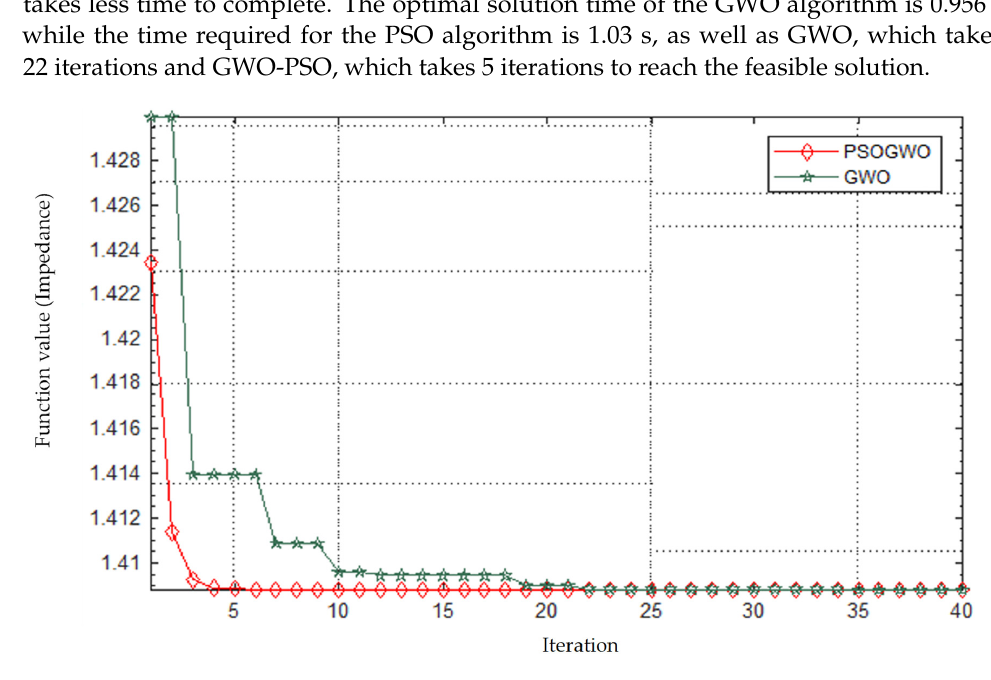
Figure 6. Parameter optimization convergence graph for the GWO and GWOPSO algorithm.